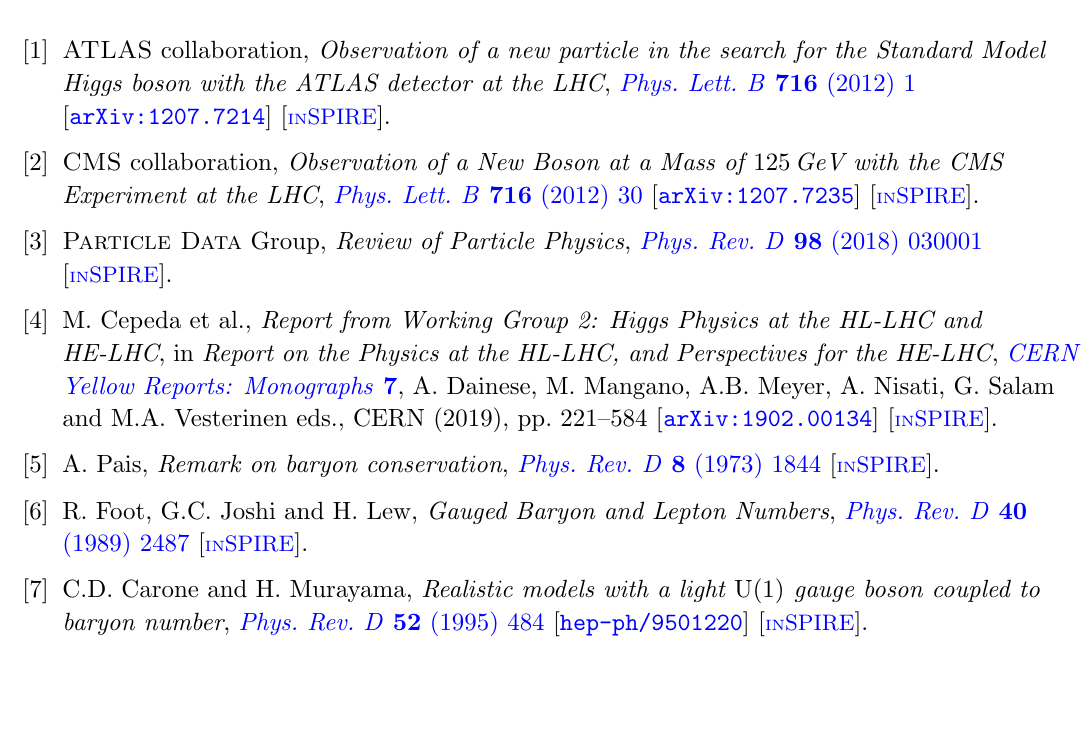
Figure 14 . Experimental constraint on the kinetic mixing, sin (cid:15) , as a function of the Z have used the measurement of the Z boson